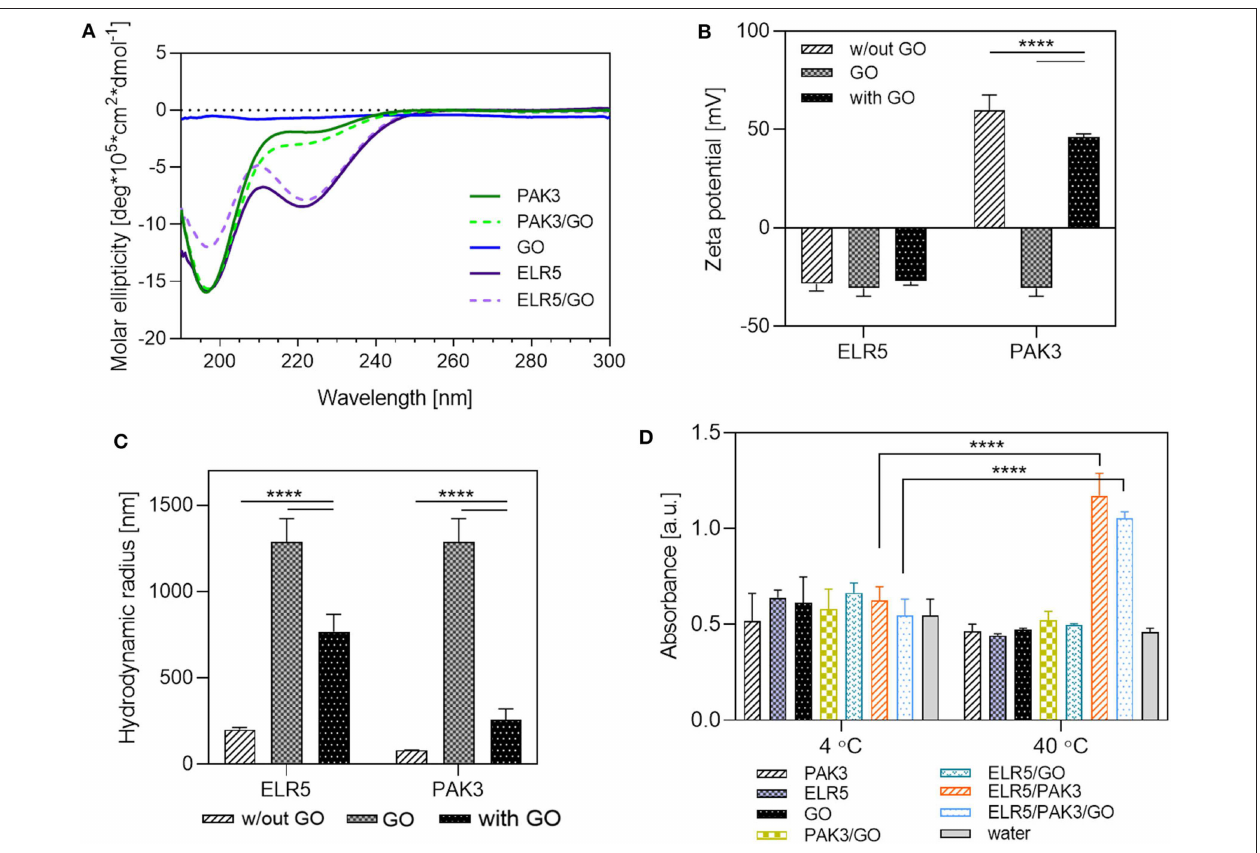
FIGURE 2 | Analysis of interactions between PAK3, ELR5, and GO. (A) CD spectra of PAK3, ELR5, and their mixtures with GO in aqueous solutions at room temperature. (B) Zeta potential measurements of aqueous solutions of PAK3, ELR5, and their mixtures with GO. (C) DLS measurements of aqueous solutions of PAK3, ELR5, and their mixtures with GO (D) Turbidity of aqueous solutions of PAK3, ELR5, and their mixtures with GO at 4 and 40 ◦ C measured at 300nm. Error bars represent ± SD where **** p < 0.0001. The experiments were performed in